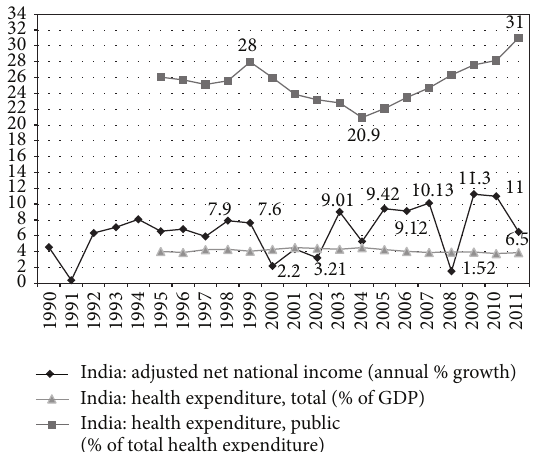
Figure 4: Variation in India’s health expenditure with GDP growth rate. Source: all the figures have been obtained from Health Nutri- tion and Population Statistics in World Bank DataBank. Avail- ableathttp://databank.worldbank.org/data/views/variableselection/ selectvariables.aspx?source=health-nutrition-and-population-sta- tistics since 15th August